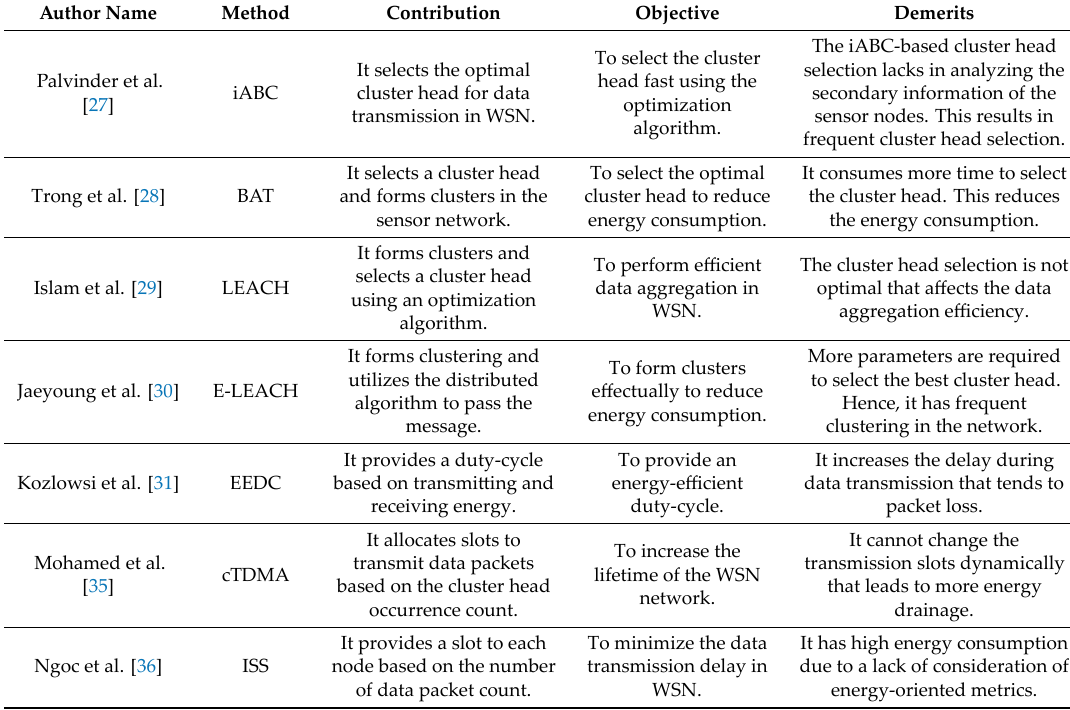
Table 1. Description and demerit of the related